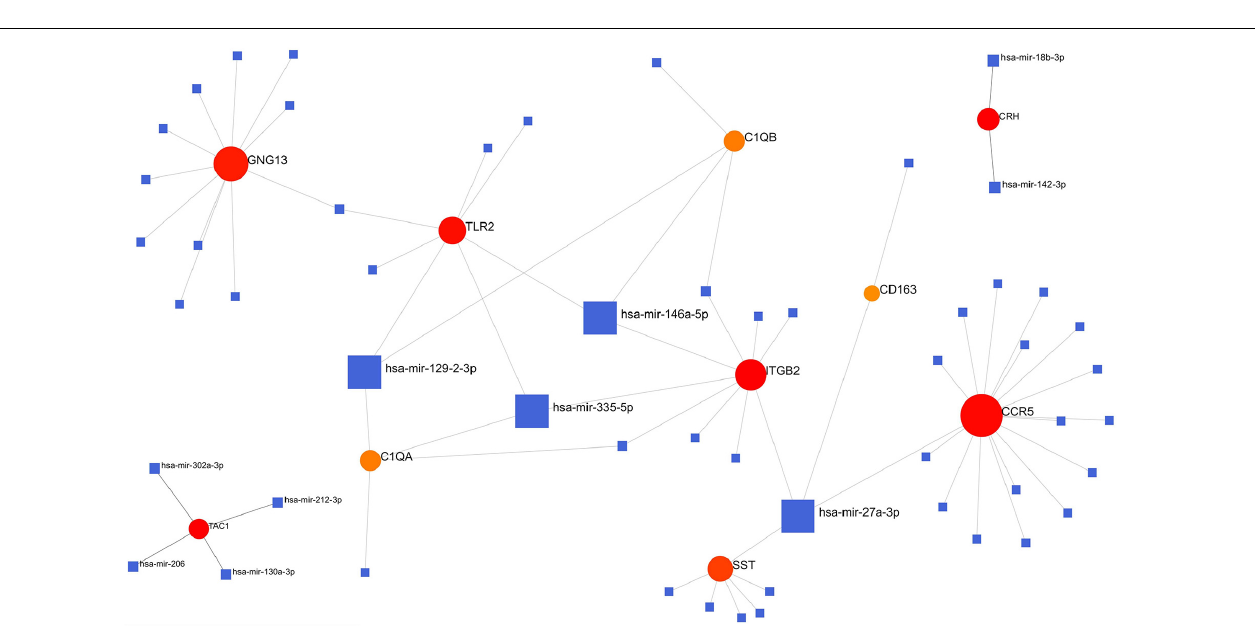
Frontiers in Molecular Neuroscience |